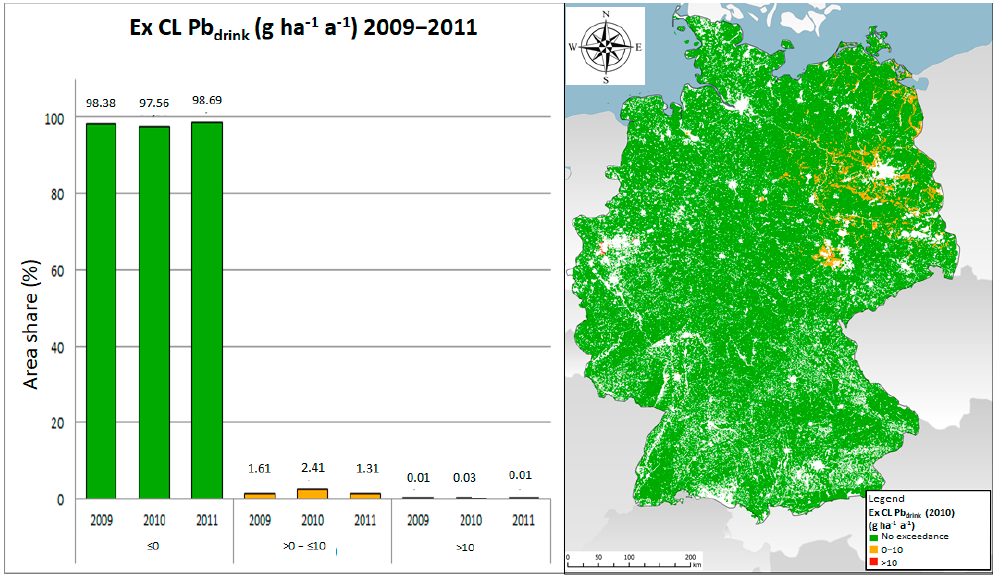
Figure 3. Exceedance of Critical Loads with the protection objective of drinking water quality by atmospheric Pb deposition.